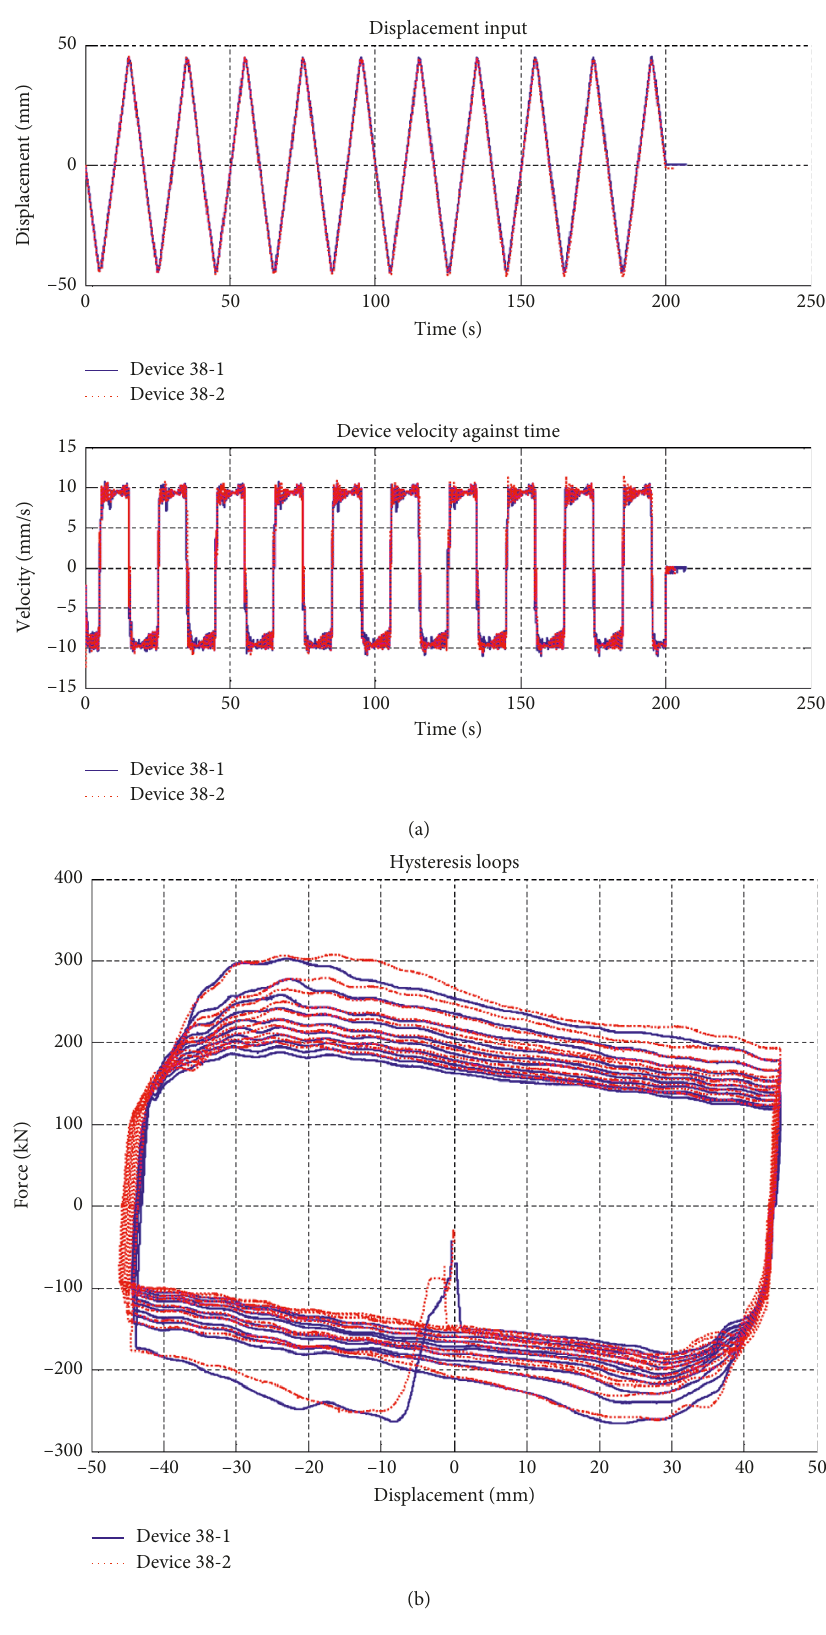
Figure 9: Two identical devices subjected to 10 fully reversed, near full-stroke displacement cycles at